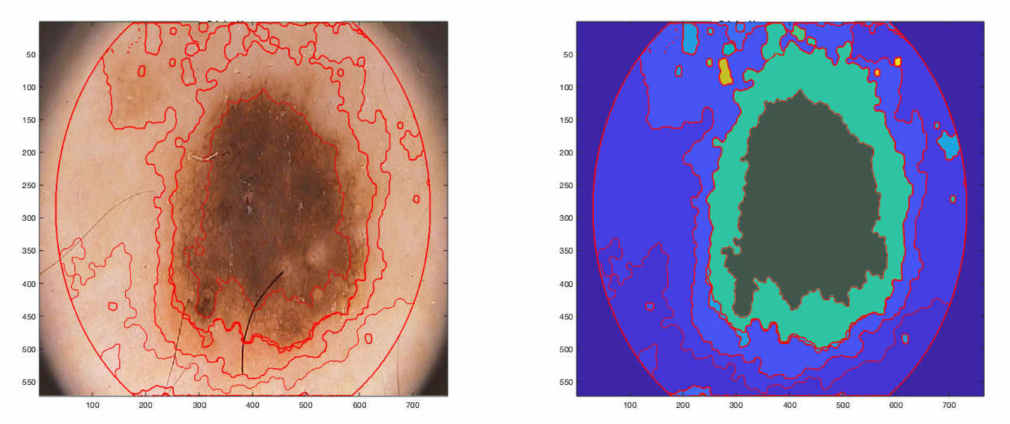
Figure 3. Image segmentation into color coherent areas by the proposed approach. The outer circular area is the selected